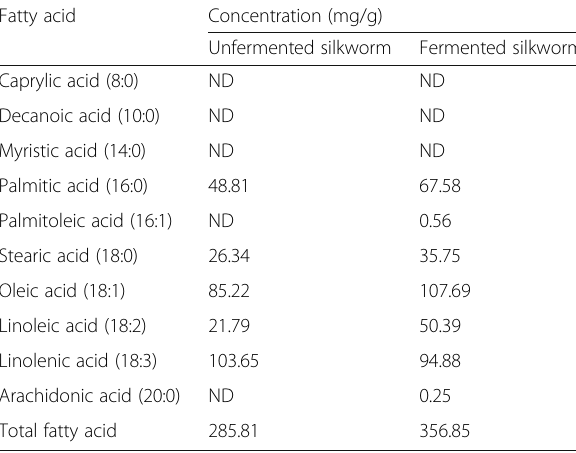
Table 2 Free amino acid contents of unfermented, and fermented silkworm